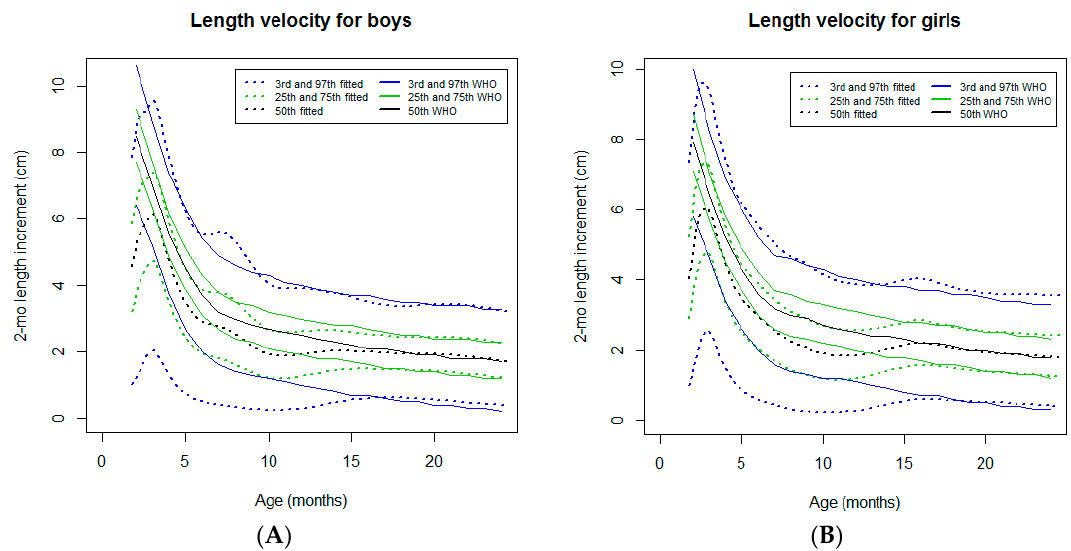
Figure 8. Comparison of the WHO Child Growth Standards (solid lines) with smoothed centile curves (dotted lines) of measured 2-month length velocity for boys ( A ) and girls ( B ) from the neonatal period to 24 months of age.